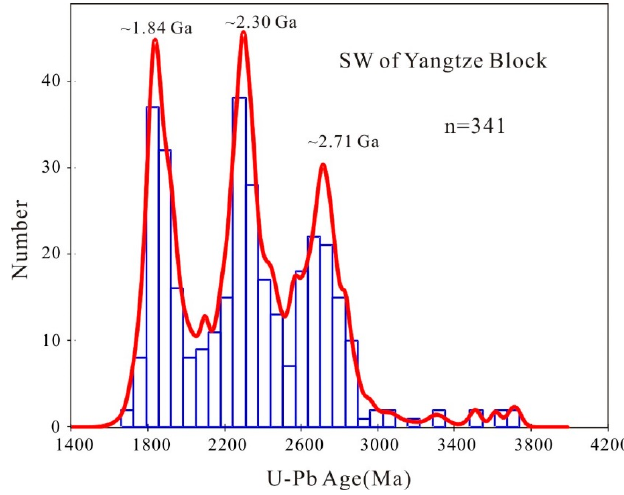
Figure 11. Histogram of compiled concordant detrital zircon U–Pb ages > 1700 Ma in the SW Yangtze Block. Data are from [22,28] and the present study. Block. Data are from [22,28] and the present